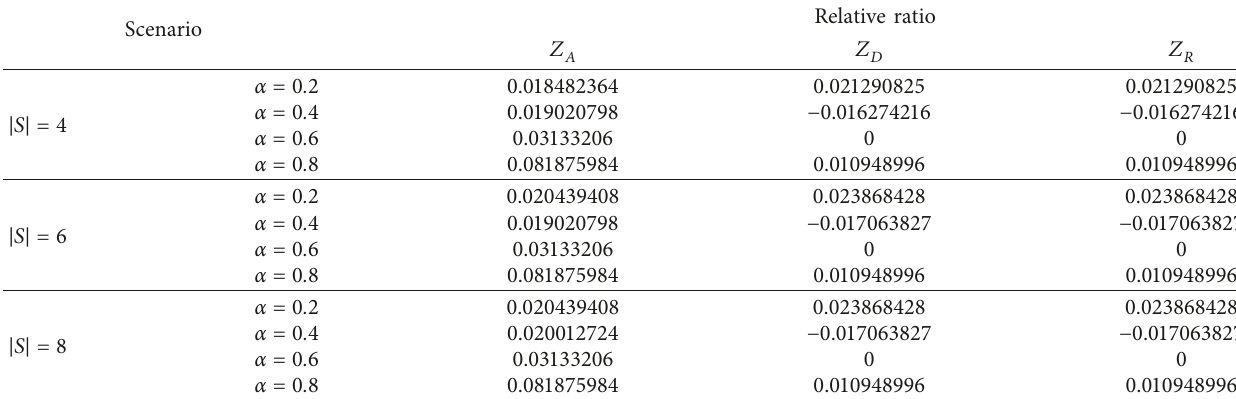
Table 8: The ratio P of performance for robust